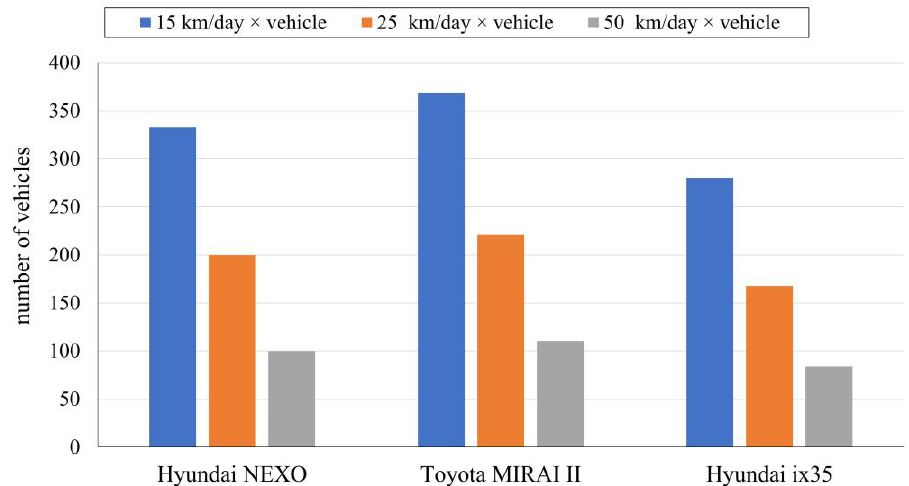
Figure 9. Number of vehicles that can be fueled with excess hydrogen on Anafi in relation to average daily mileage.